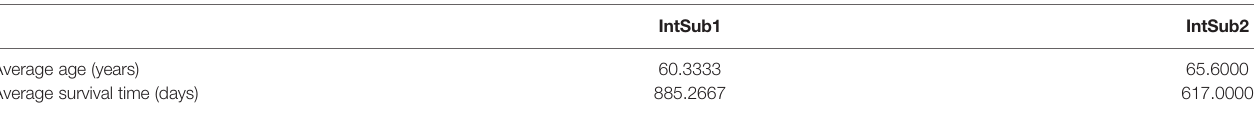
TABLE 2 | Average diagnosis ages and survival time of the UM patients in the two integrated